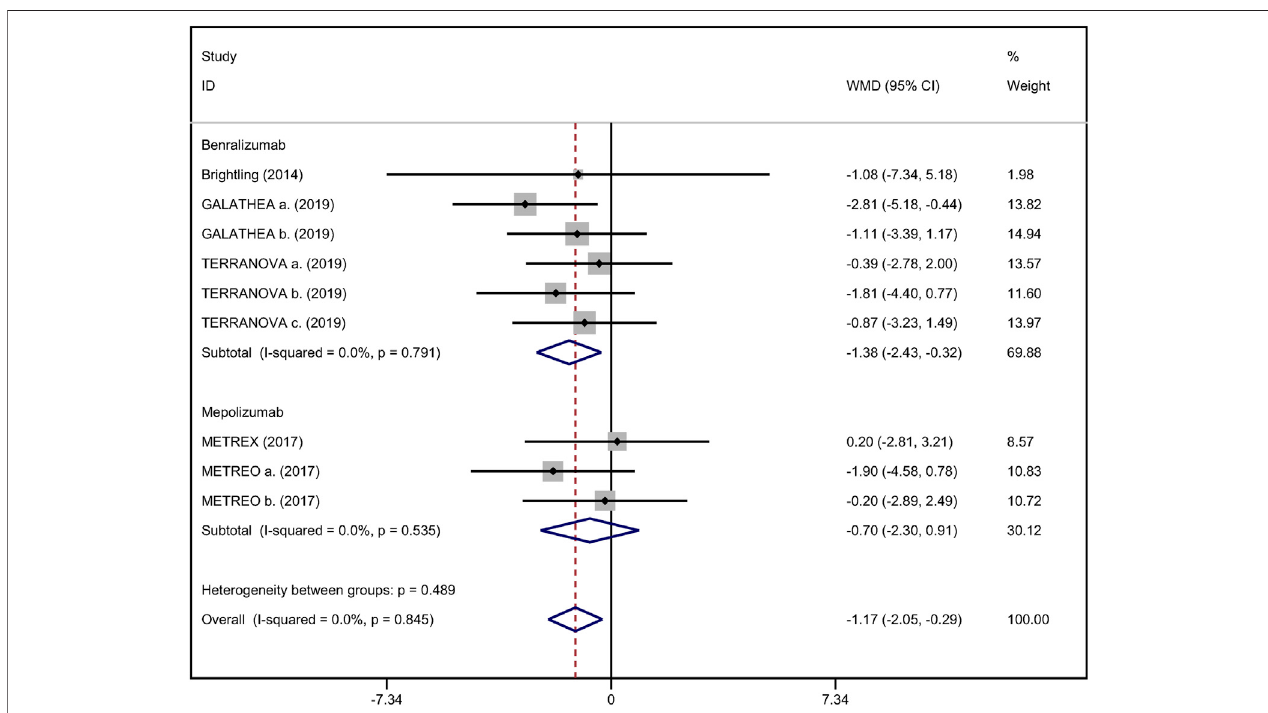
FIGURE 4 | Forest plot of SGRQ score in eosinophilic COPD patients with anti-IL-5 therapy vs. placebo.